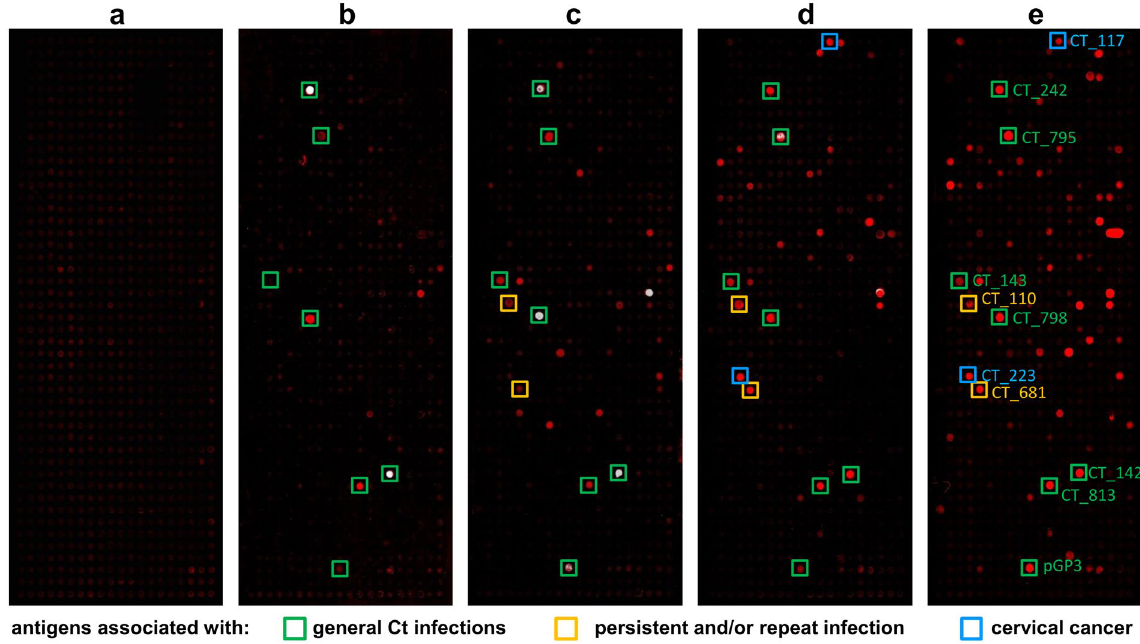
Figure 3. Proteome Immunoassays (PIA) using pools of five sera. In total 897 Ct proteins and one Cp protein were spotted on one array. ( a ) No signal was obtained with a pool of five sera from Ct-uninfected women. ( b ) Result of PIA with a pool of 5 sera from cancer-free women infected with Ct and < 25 years of age. ( c ) Same as b, but women > 40 years of age. ( d , e ) Results of PIAs with two different pools of samples from Ct-infected cervical cancer patients. Examples for antigens associated with general Ct infections ( b – e ), potentially persistent infections ( c – e ) and cervical cancer ( d , e ) are highlighted with green, yellow, and blue boxes,